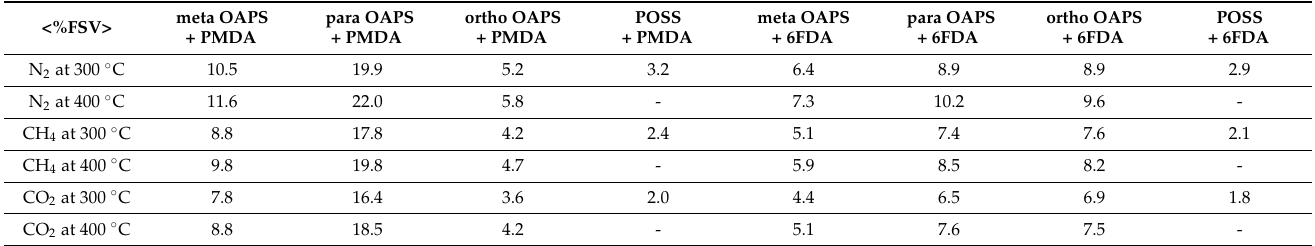
Table 2. Average percentages of significant volume < %FSV > in the pure polyOAPS/POSS-imides matrices available for the insertion of N 2 , CH 4 and CO 2